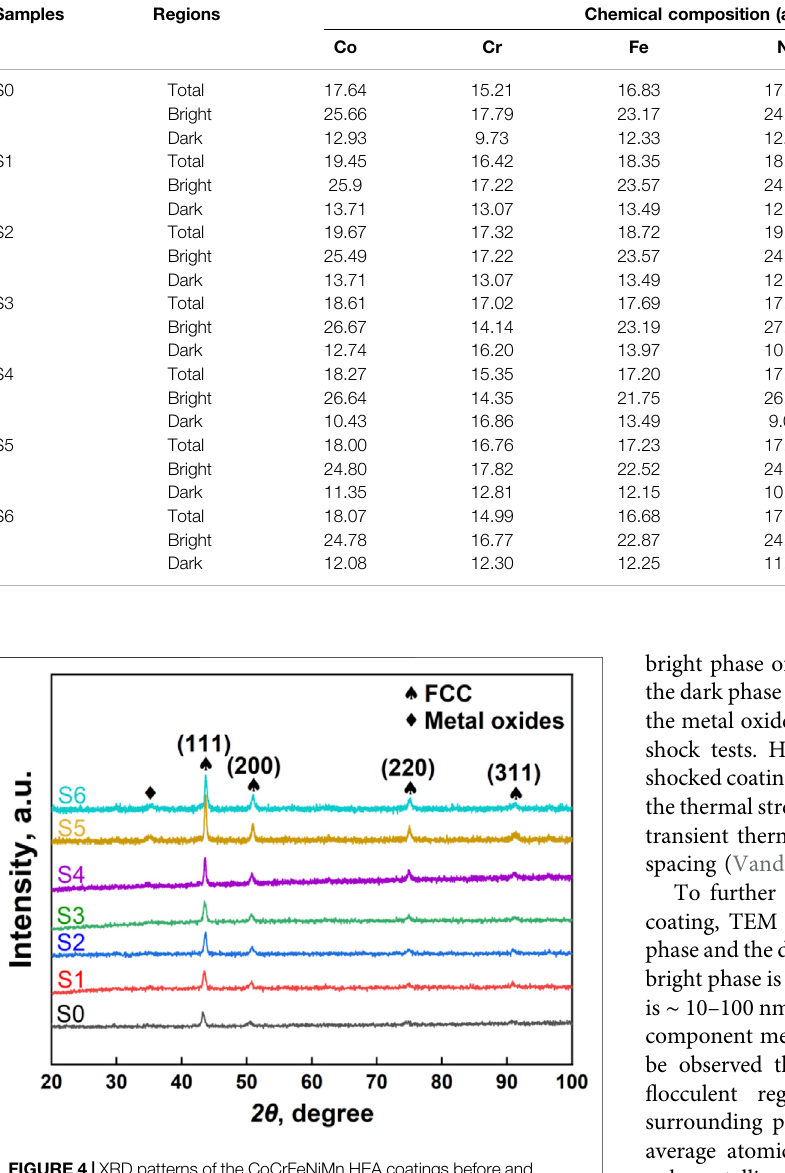
Frontiers in Materials |